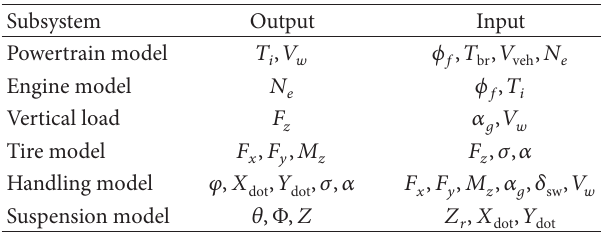
Table 1: Data list of inputs and outputs in the UTMVDM for